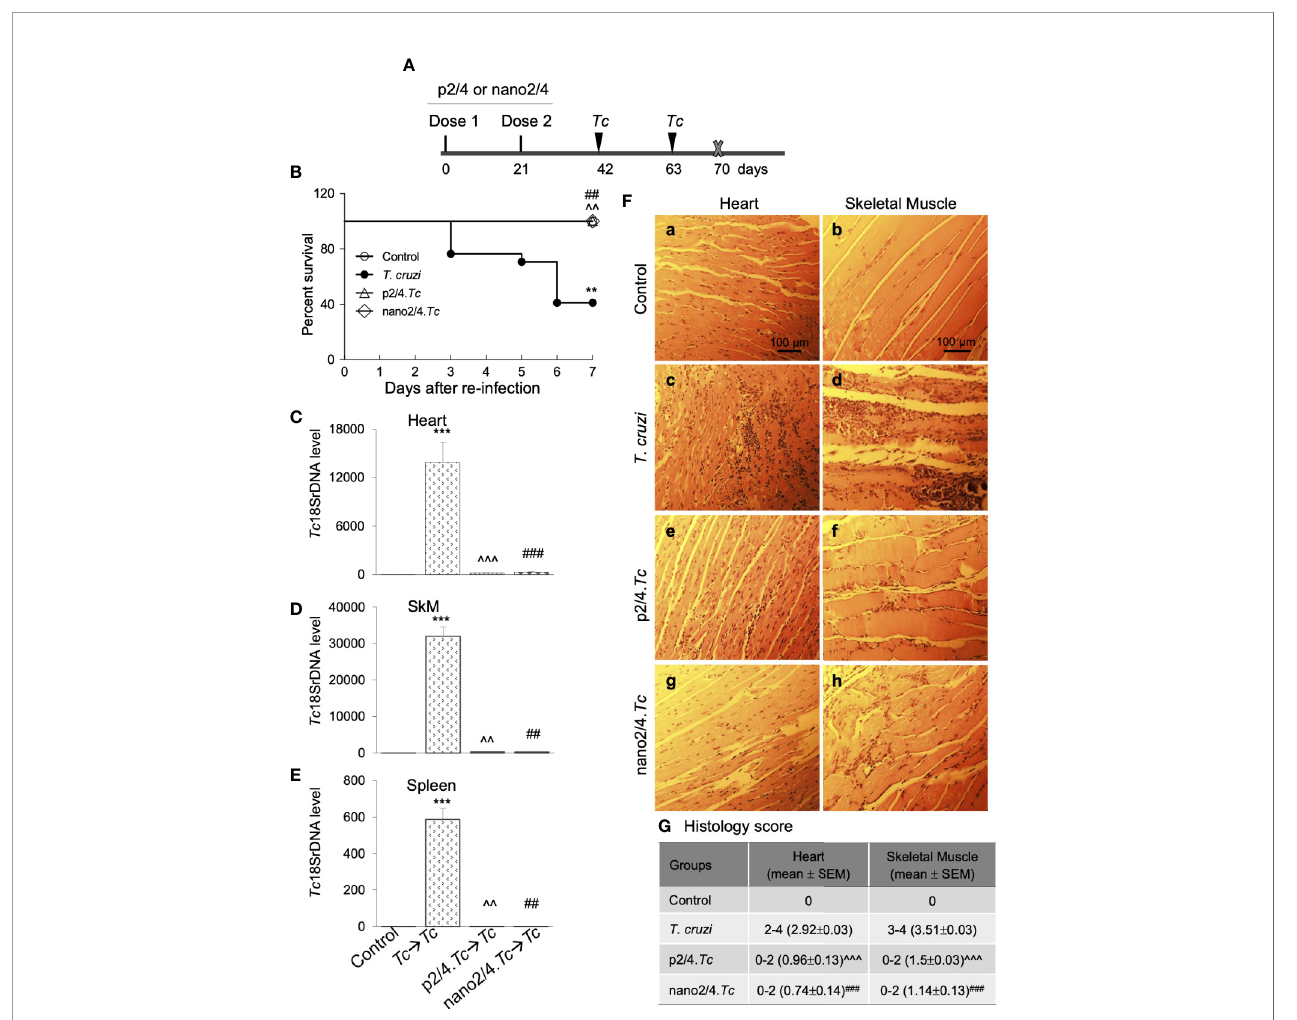
FIGURE 4 | Prophylactic ef fi cacy of nanovaccine against T. cruzi re-challenge infection. (A) Schematic of experimental design. C57BL/6 mice were vaccinated with p2/4 or nano2/4 on day 0 and day 21 and infected with T. cruzi (10,000 trypomastigotes per mouse) on day 42 and day 63. Mice were euthanized on day 70 corresponding to 7 days after 2 nd challenge. (B) Kaplan Meier survival curve for all groups of mice ( n ≥ 5 mice per group). (C – E) Tissue parasite burden. The qPCR evaluation of Tc18SrDNA levels in heart (C) , skeletal muscle (D) , and spleen (E) tissues at 7 days after re-challenge was performed as described in Materials and Methods. Bar graphs show mean value ± SEM derived from ≥ 2 observations per sample ( n = 5 mice/group/experiment). (F, G) Tissue in fl ammatory in fi ltrate after re- challenge with T. cruzi . Paraf fi n-embedded 5-µm tissue sections were obtained 7 days after re-challenge and examined by H&E staining. Shown in (F) are representative images of the heart and skeletal muscle tissue sections from non-vaccinated/non-infected (a, b), non-vaccinated/ T. cruzi- infected (c, d), p2/4. Tc (e, f), and nano2/4. Tc (g, h) groups of mice (magni fi cation: 20×). In fl ammatory score was calculated as described in Materials and Methods, and presented in (G) . Signi fi cance was calculated by student ’ s t-test (* no infection vs. Tc ) and one-way ANOVA/Tukey ’ s ( ^ Tc vs. p2/4. Tc and # Tc vs. nano2/4 .Tc ) and one, two, and three symbol characters annotate the p values of <0.05, <0.01, and <0.001,